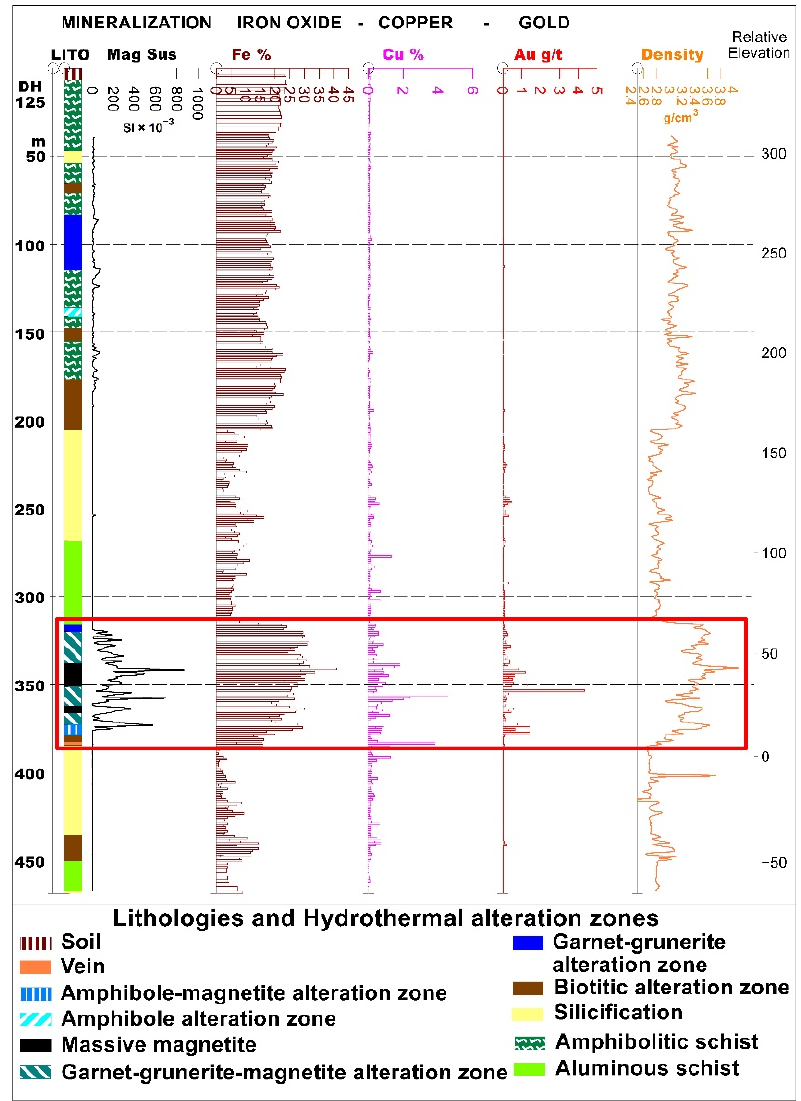
Figure 10. Sampling on the drill hole 125 log with the IOCG mineralization footprints: Hydrothermal alterations, magnetic susceptibility in SI × 10 − 3 , iron-grade geochemical assays in percentage, copper grade in percentage, gold in grams per ton, and density in grams per cubic centimeter. The red box shows the strong correlation between high-grade mineralization and high magnetic susceptibility.